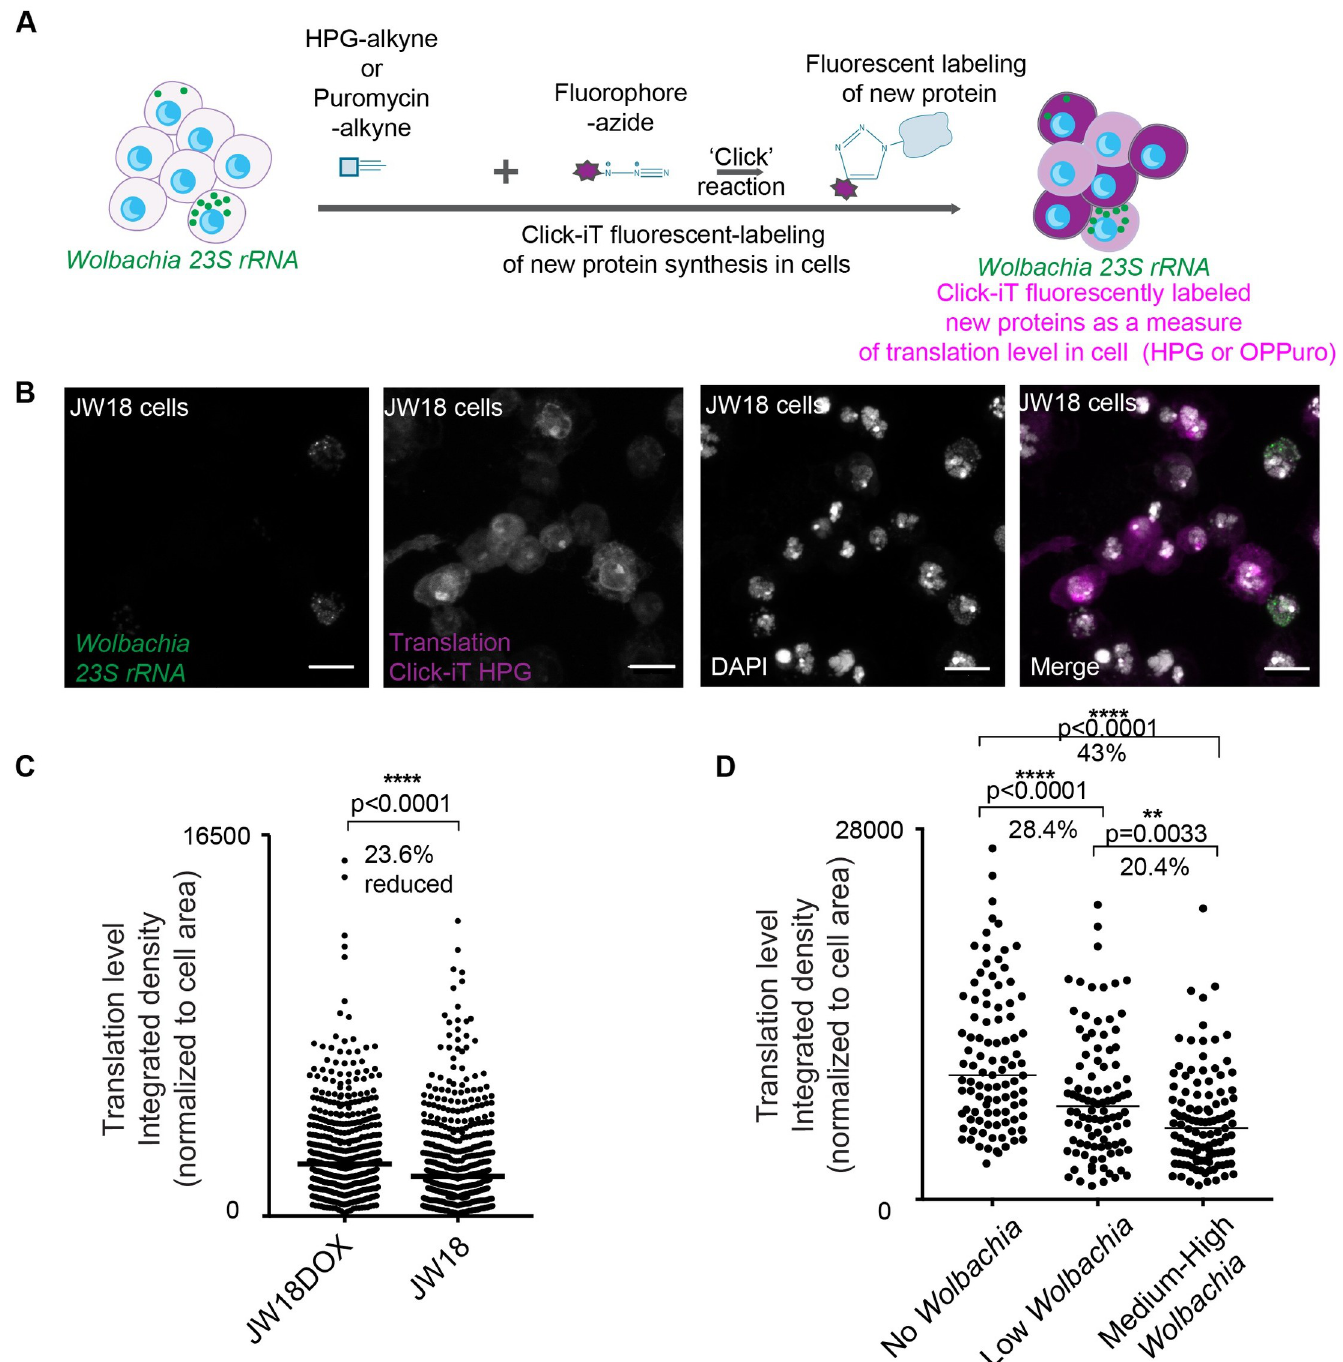
Fig 7. Wolbachia levels negatively correlate with host translation levels in JW18 cells. (A) Illustration of Click-iT method that fluorescently labels newly synthesized proteins in host cells as a measure of translation level. JW18 cells were incubated with a modified methionine called HPG containing an alkyne or whole testes were incubated with a modified puromycin containing an alkyne. In each case these alkyne-containing reagents were incorporated into newly synthesized proteins during incubation. Thereafter, samples were processed for the ‘click’ reaction by adding an azide-tagged fluorophore (purple) which reacted with the incorporated alkynes to label new proteins fluorescently (purple). The fluorescent intensity is used as a measure of translation level within the host cell. This assay is combined with Wolbachia - detecting 23s rRNA FISH assay (green). ( B) JW18 cells labeled by Click-iT HPG (purple), DAPI (white), and Wolbachia -detecting 23s rRNA FISH assay (green). Scale bars represent 10 μ m. ( C ) Quantification of HPG Click-iT assay fluorescent signal for protein synthesis within individual cells of Wolbachia -free JW18DOX cell line compared to Wolbachia -infected JW18 cell line showing a significant 23.6% decrease in translation level in JW18 cell line (Non-parametric, Mann Whitney,